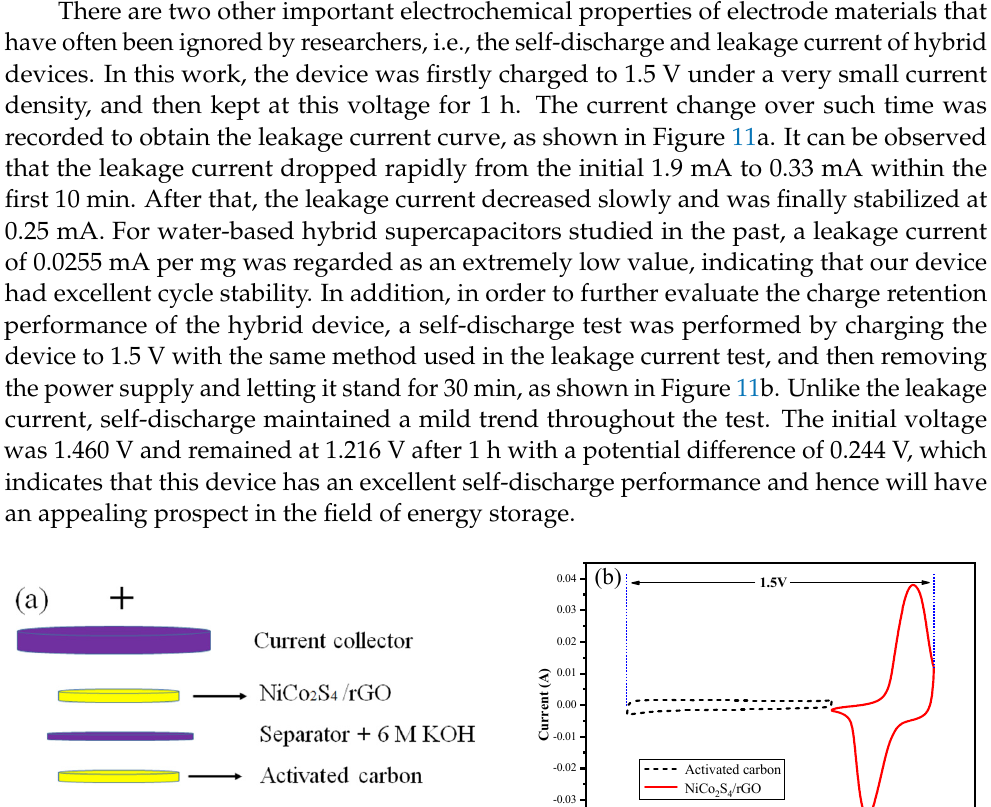
Figure 9. ( a ) CV curves at various scan rates, ( b ) galvanostatic charge and discharge diagram at dif- ferent current densities, ( c ) EIS spectra, and ( d ) cycling performance of the NiCo 2 S 4 /rGO composites; SEM images of NiCo 2 S 4 /rGO composites ( e ) before and ( f ) after 1000 charge-discharge cycles.